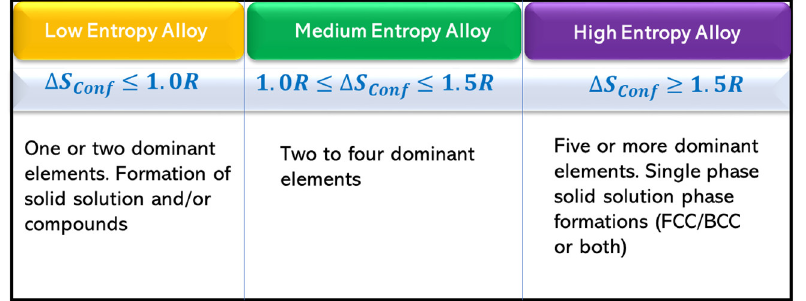
Figure 1. Differences between low-, medium-, and high-entropy alloys based on their configura- tional entropy. tional